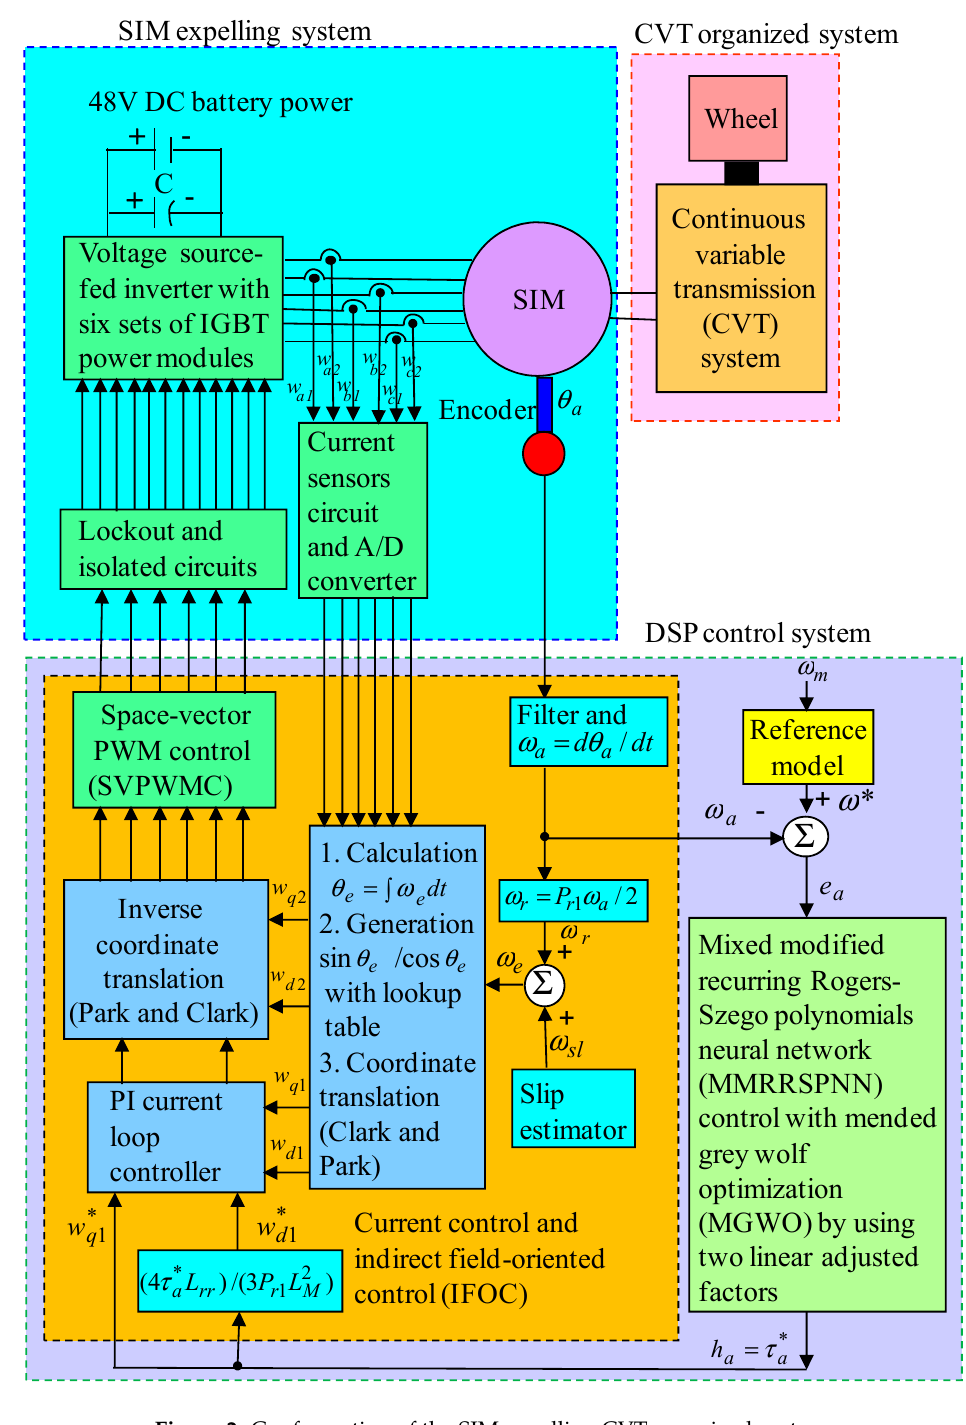
Figure 2. Conformation of the SIM expelling CVT organized system.